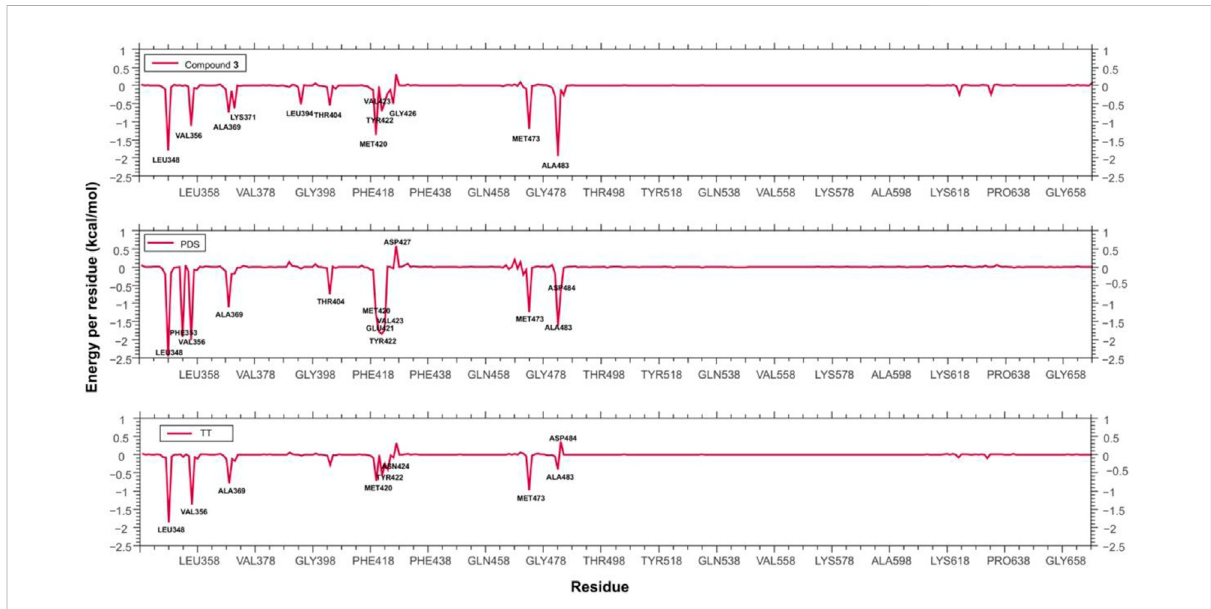
FIGURE 11 Per residue contributions tothe freeenergy ofbinding: sameasFigure 9for thecase ofthecomplexesPKC- β 2/compound 3, PKC- β 2/PDSand PKC- β 2/TT.